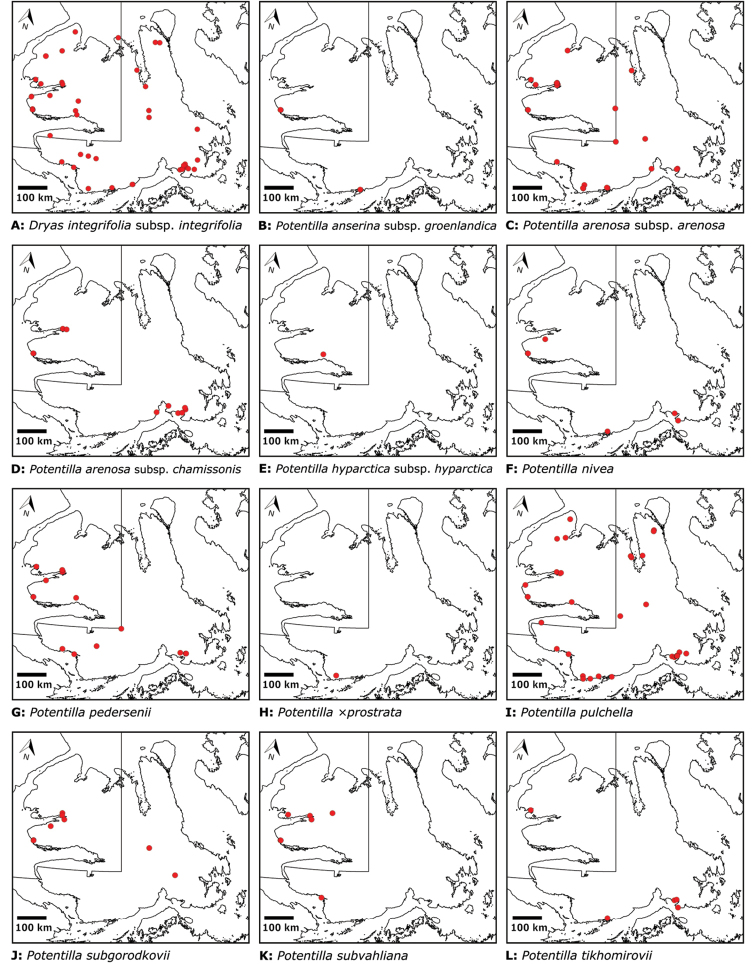
Species distribution maps. Rosaceae: ADryas
integrifolia
subsp.
integrifoliaBPotentilla
anserina
subsp.
groenlandicaCPotentilla
arenosa
subsp.
arenosaDPotentilla
arenosa
subsp.
chamissonisEPotentilla
hyparctica
subsp.
hyparcticaFPotentilla
niveaGPotentilla
pederseniiHPotentilla
×
prostrataIPotentilla
pulchellaJPotentilla
subgorodkoviiKPotentilla
subvahlianaLPotentilla
tikhomirovii.